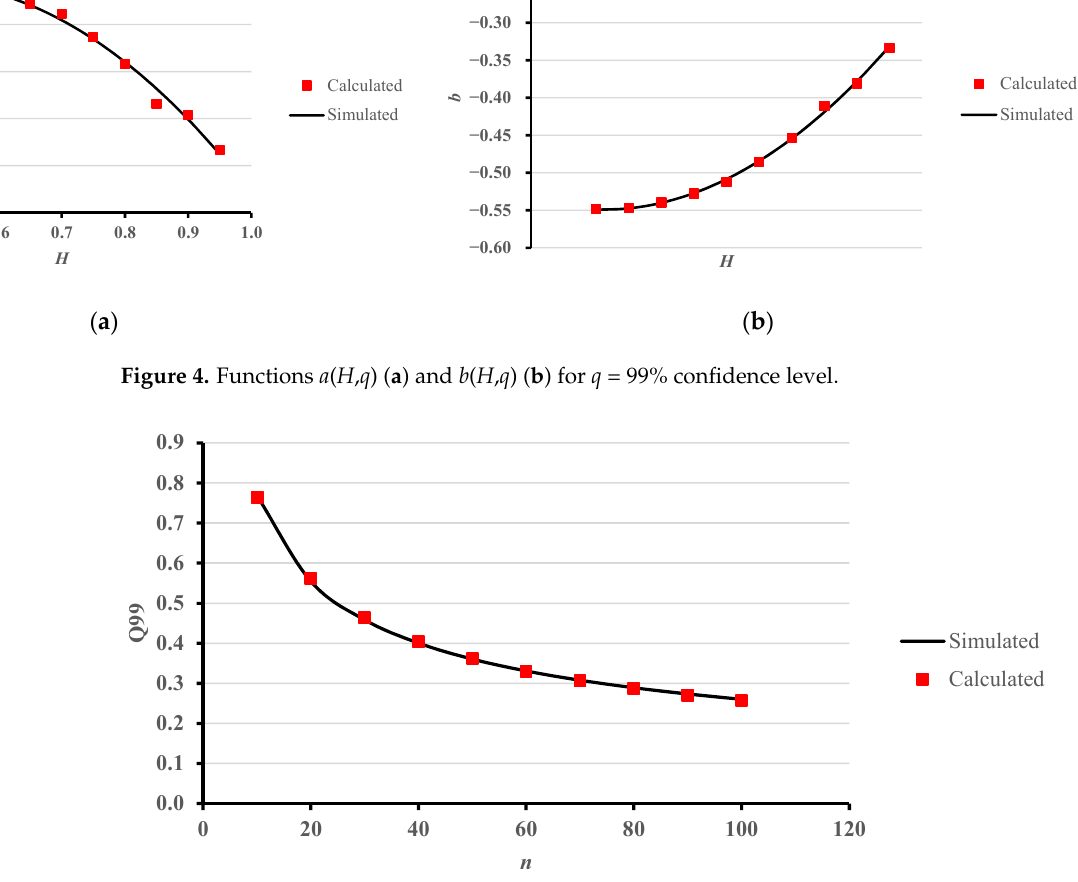
Figure 5. Quantile ( c ) of the estimator of the linear cross–correlation coefficient for q = 99% confi- dence level.